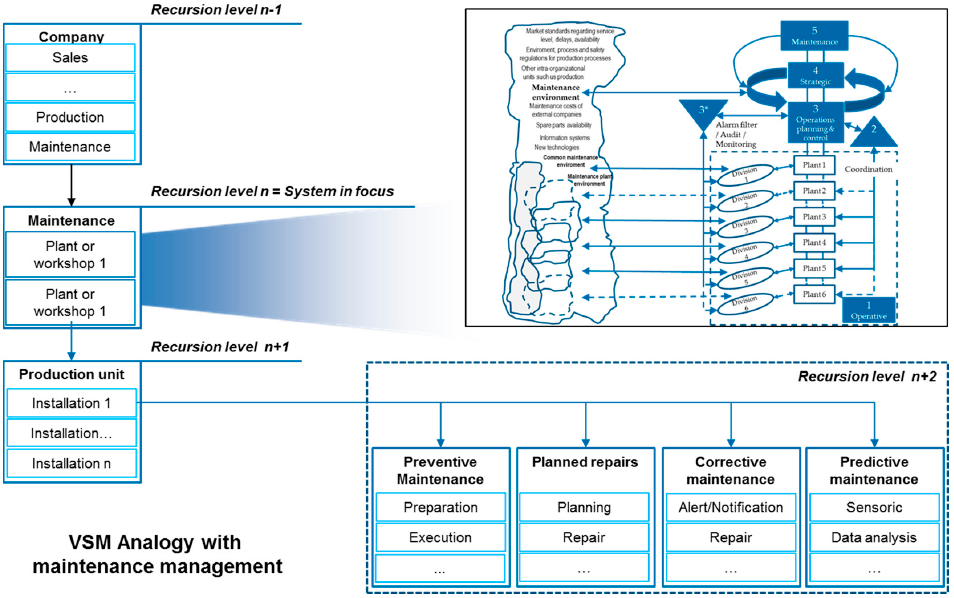
Figure 6. VSM recursion levels for company, production and maintenance (own elaboration).